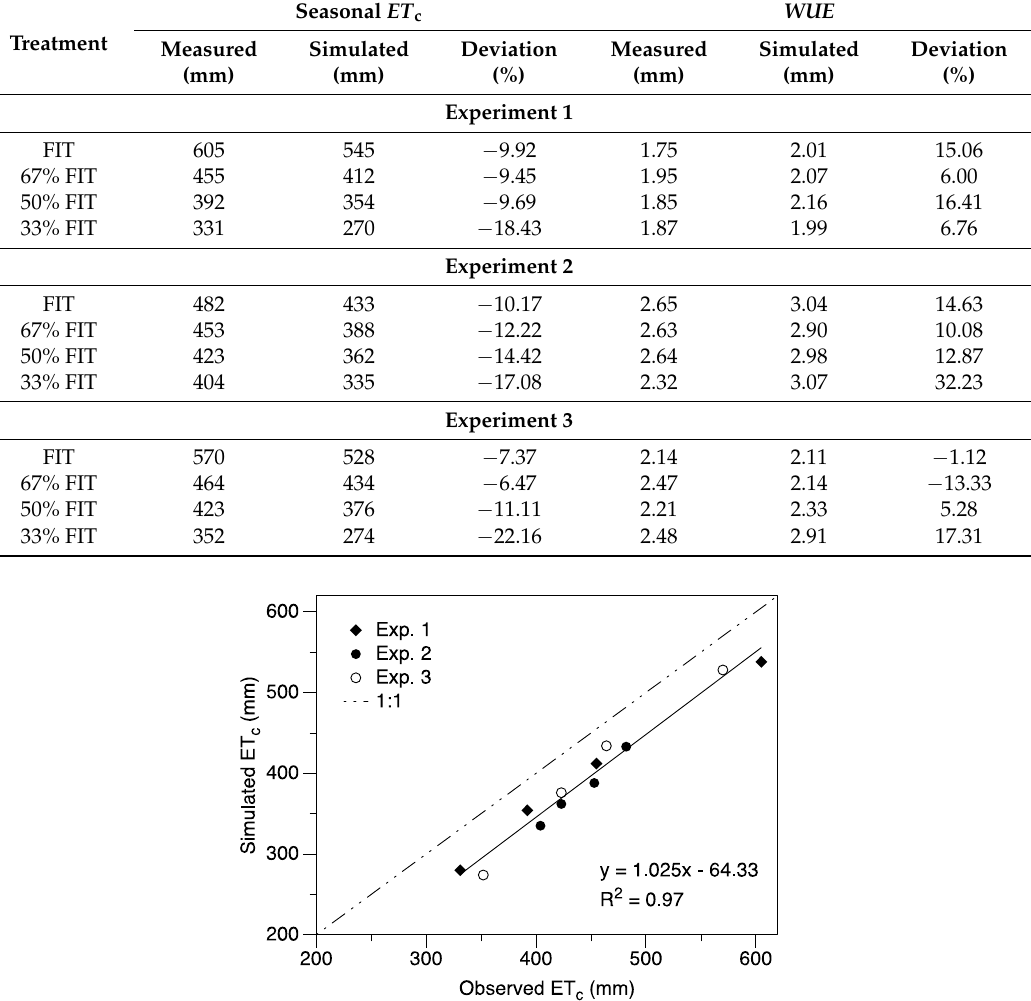
Table 6. Comparison between simulated and estimated crop evapotranspiration ( ET c ) and water use efficiency ( WUE ) over three cropping seasons.